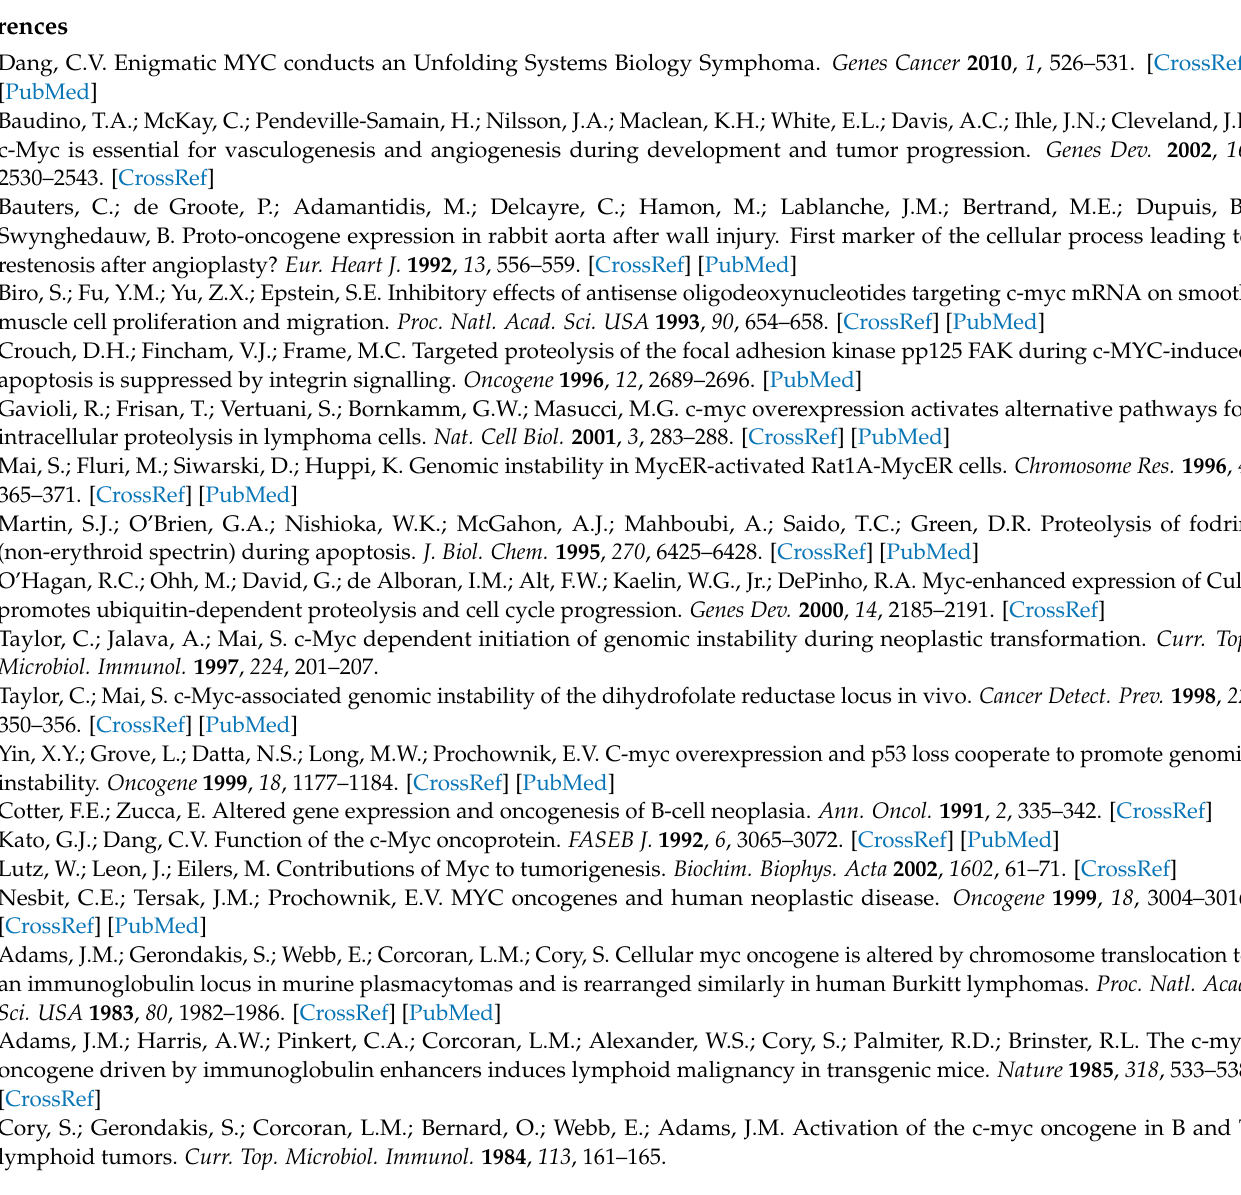
topology, Figure S2: Activity of DNAi 1T, 3T and 4T in lymphoma cells, Figure S3: Evaluation of 5Tscr G4 recognition, Figure S4: Affinity of unlabeled and labeled